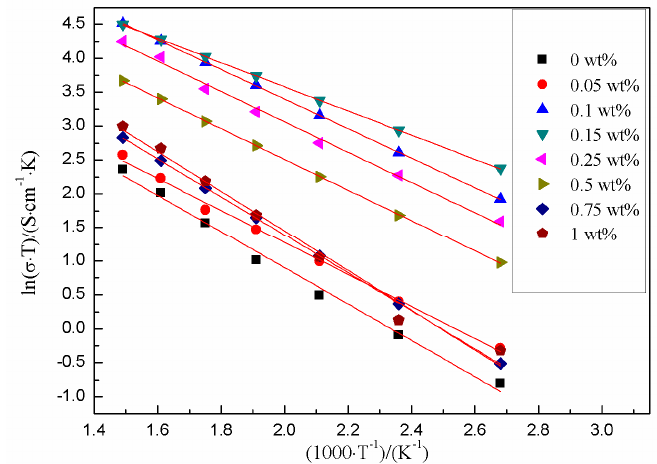
Figure 8. Arrhenius plot of resistivity data for the sinters with different amounts of Cr 2 O 3 doping. Table 3. Some calculated parameters and measured properties of the sinters with different amounts of Cr 2 O 3 doping.